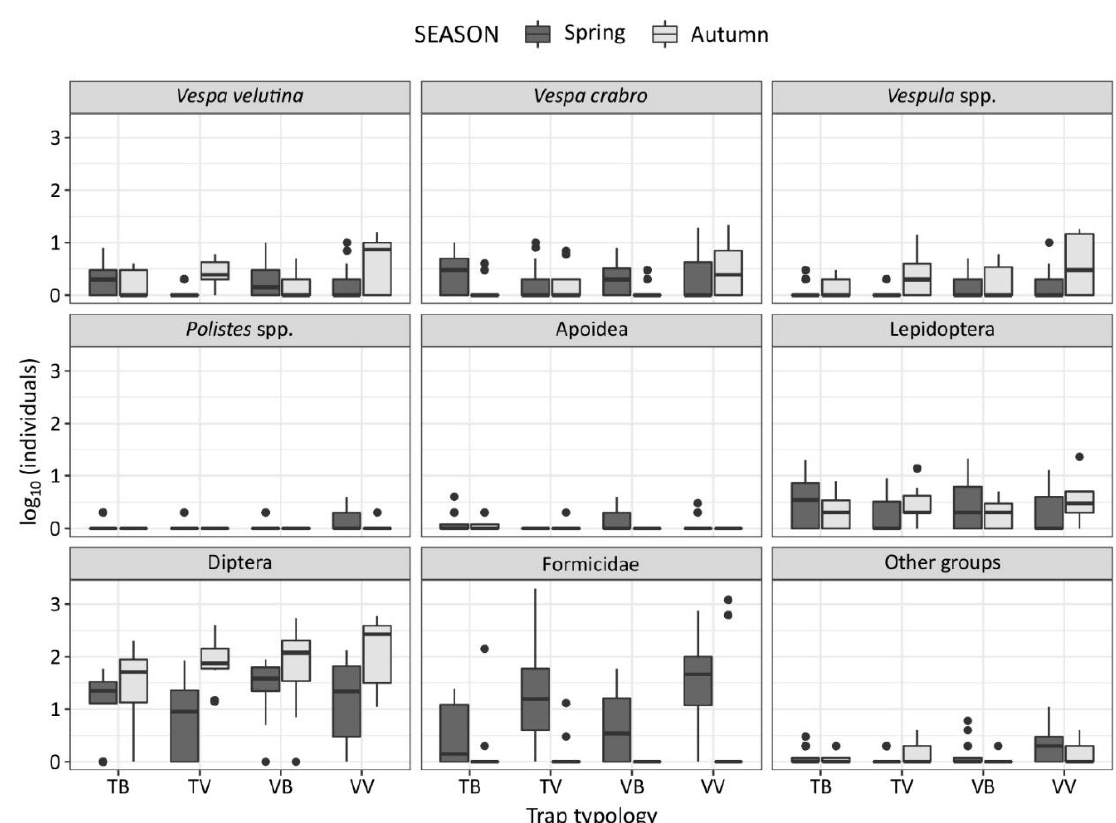
Figure 2. Number of individuals (log 10 transformed) trapped in spring (dark grey) and autumn (light grey) per species or taxonomic group, and divided among trap–bait combinations (TB: bottle trap with beer; TV: bottle trap with VespaCatch attractant; VB: VespaCatch trap with beer; VV: VespaCatch trap with VespaCatch attractant).